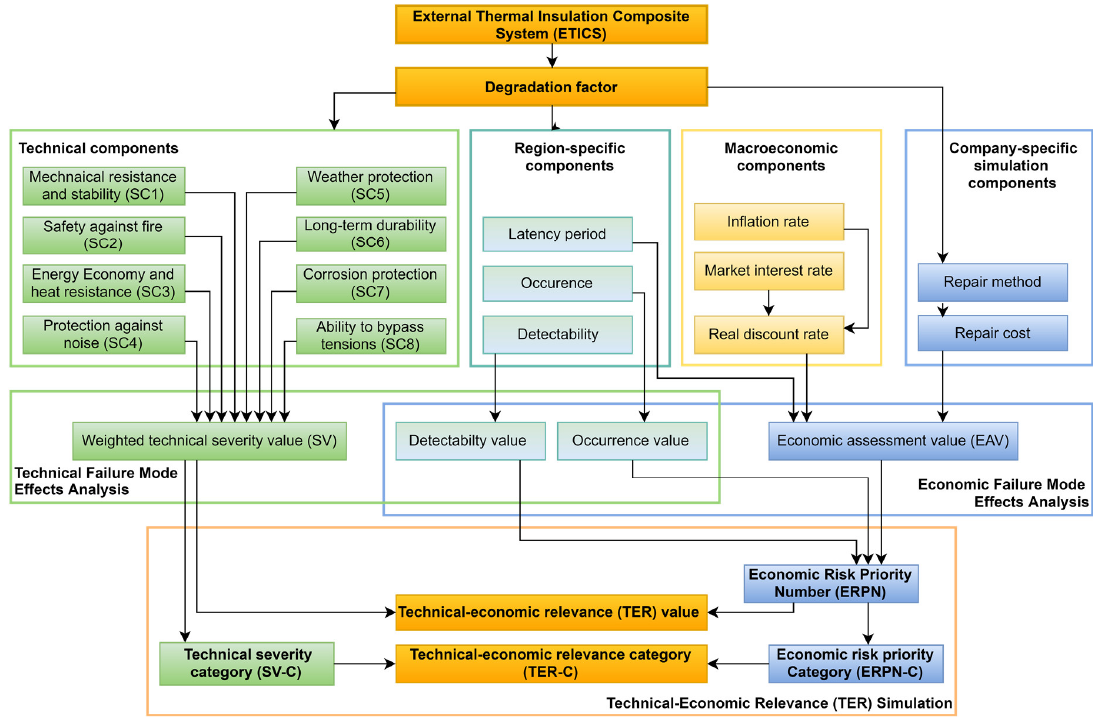
Figure 1. The framework of the technical–economic relevance (TER) model.